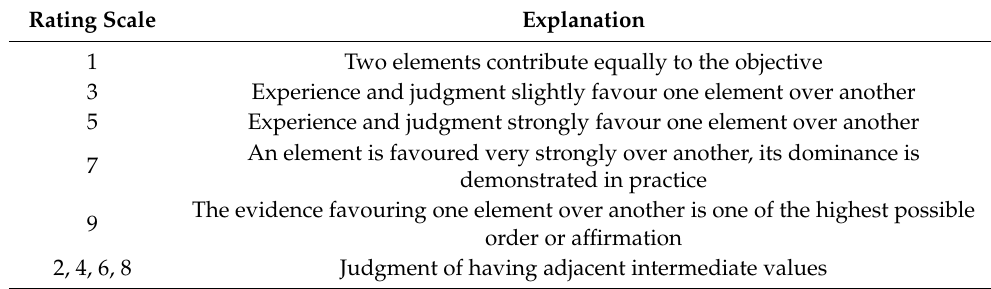
Table 2. Saaty’s scale